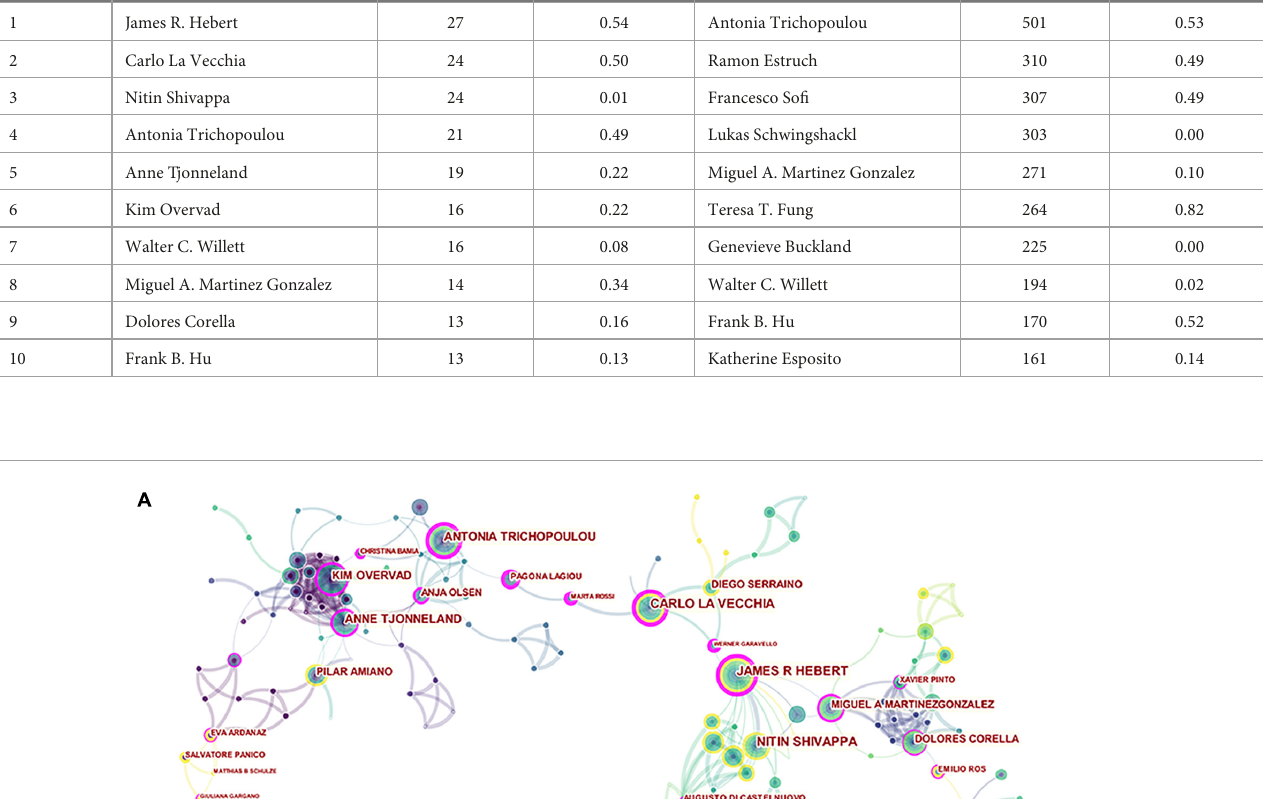
TABLE 3 Top 10 productive authors and top 10 co-cited authors related to the Mediterranean diet (MD) on cancer. Rank